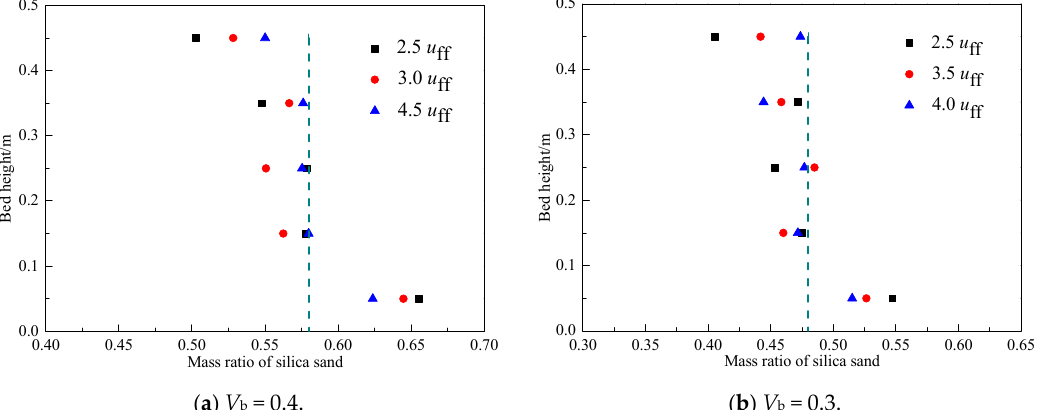
Figure 7. Qualitative mixing states of the binary mixtures ( V b = 0.3).